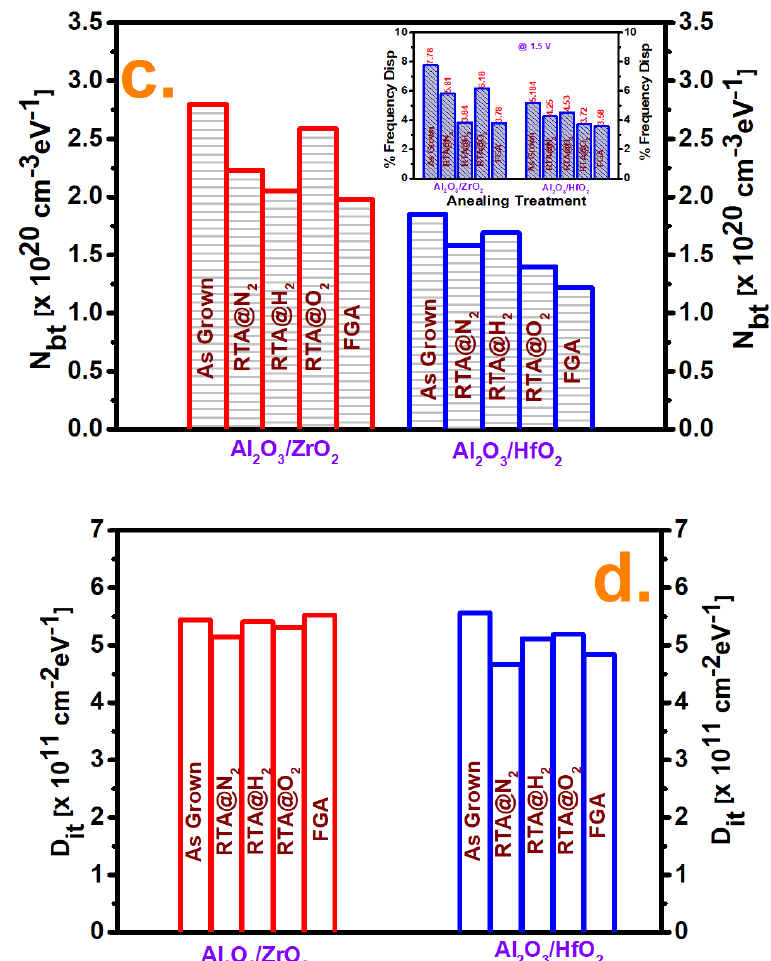
Figure 3. Fitted curves of the measured (symbols) and calculated (lines) capacitance values from the BT Distributed Border Trap model for both films for all annealing conditions including as-grown at 1.5 V for ( a ) Al 2 O 3 / ZrO 2 and ( b ) Al 2 O 3 / HfO 2 . ( c ) Border trap density (N bt ) and ( d ) interface trap density (D it ) comparison of both films for all annealing conditions including as-grown. The inset in ( c ) shows the frequency dispersion comparison for the above-mentioned criteria.